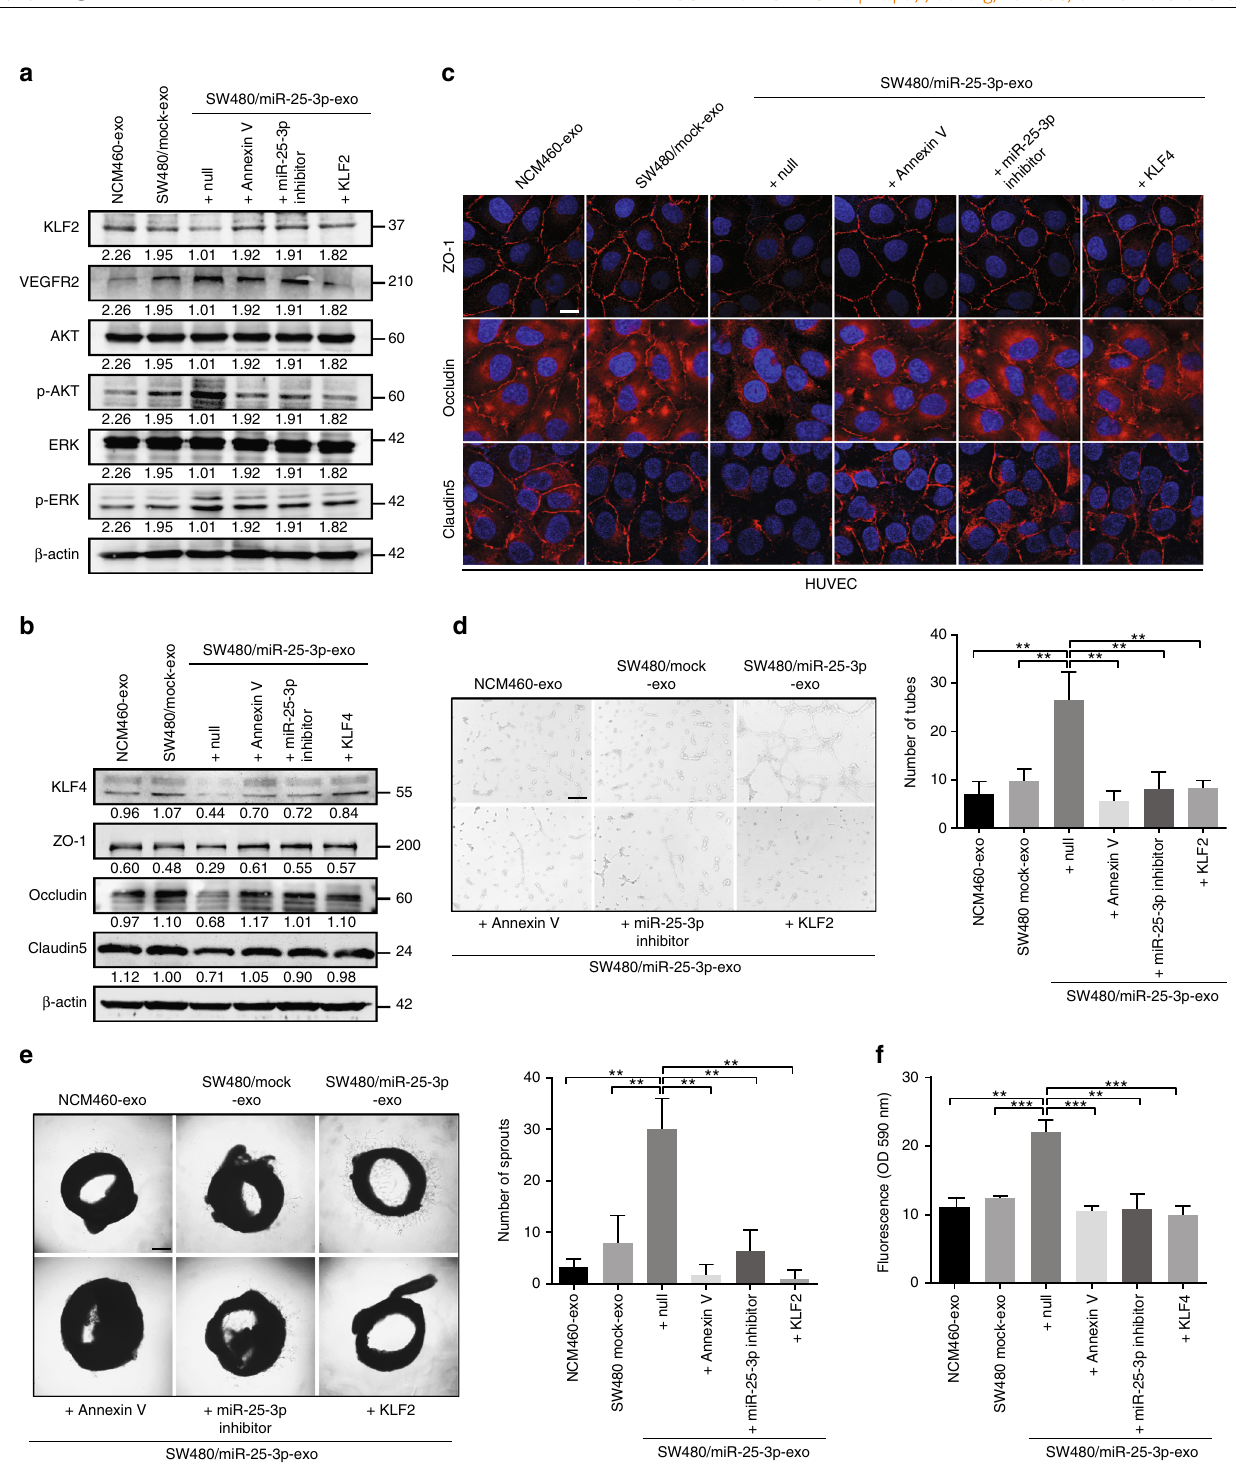
in fl ammation, fi bronectin deposition, and pericyte coverage. Cancer therapies targeting pre-metastatic niche are supposed to be a promising strategies to intervene cancer metastasis. Target- ing S1PR1-STAT3 signaling axis in myeloid cells inhibits pre- metastatic niche formation and cancer metastasis 39 . Angiopoietin-2 blockade dampens cancer-induced in fl ammatory and angiogenic response of endothelial cells in the metastatic niche 40 . Our result showed that blockade of exosomal miR-25-3p from CRC cells alleviated hepatic and pulmonary vascular per- meability and subsequent CRC metastasis, indicating that